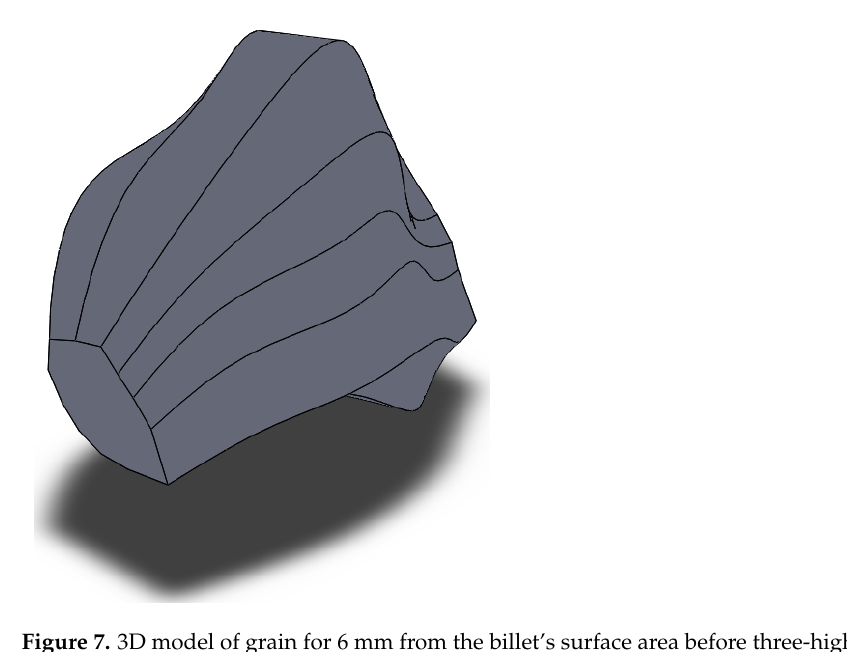
Figure 7. 3D model of grain for 6 mm from the billet’s surface area before three-high screw rolling.